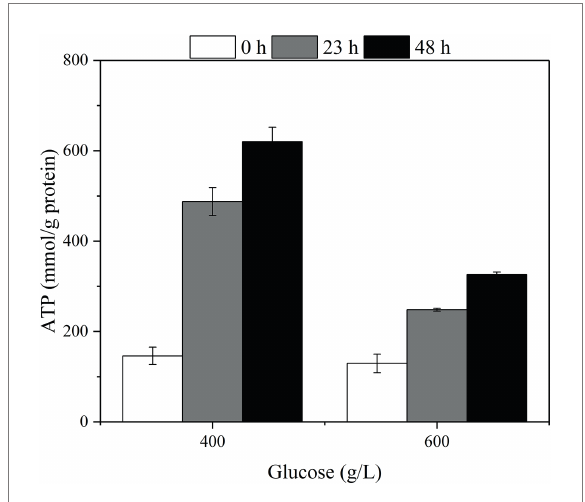
FIGURE 4 The effect of glucose titers on the viable count of the G. oxydans ( * p < 0.05, ** p < 0.01).